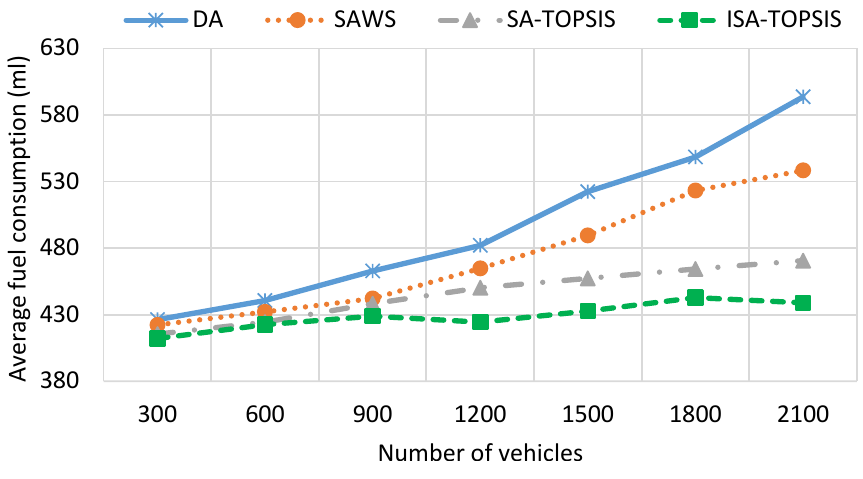
Figure 9. Average fuel